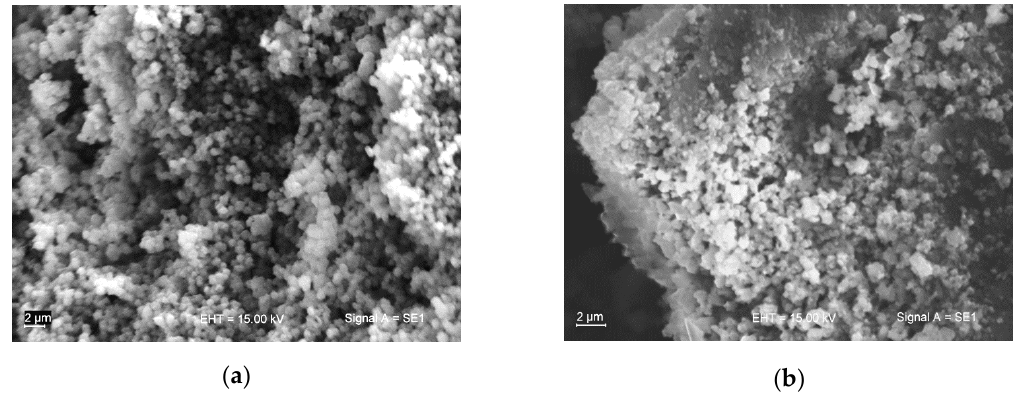
Figure 2. SEM images of ( a ) CFAZ; ( b ) magnetic nanoparticles (MNP)-CFAZ.